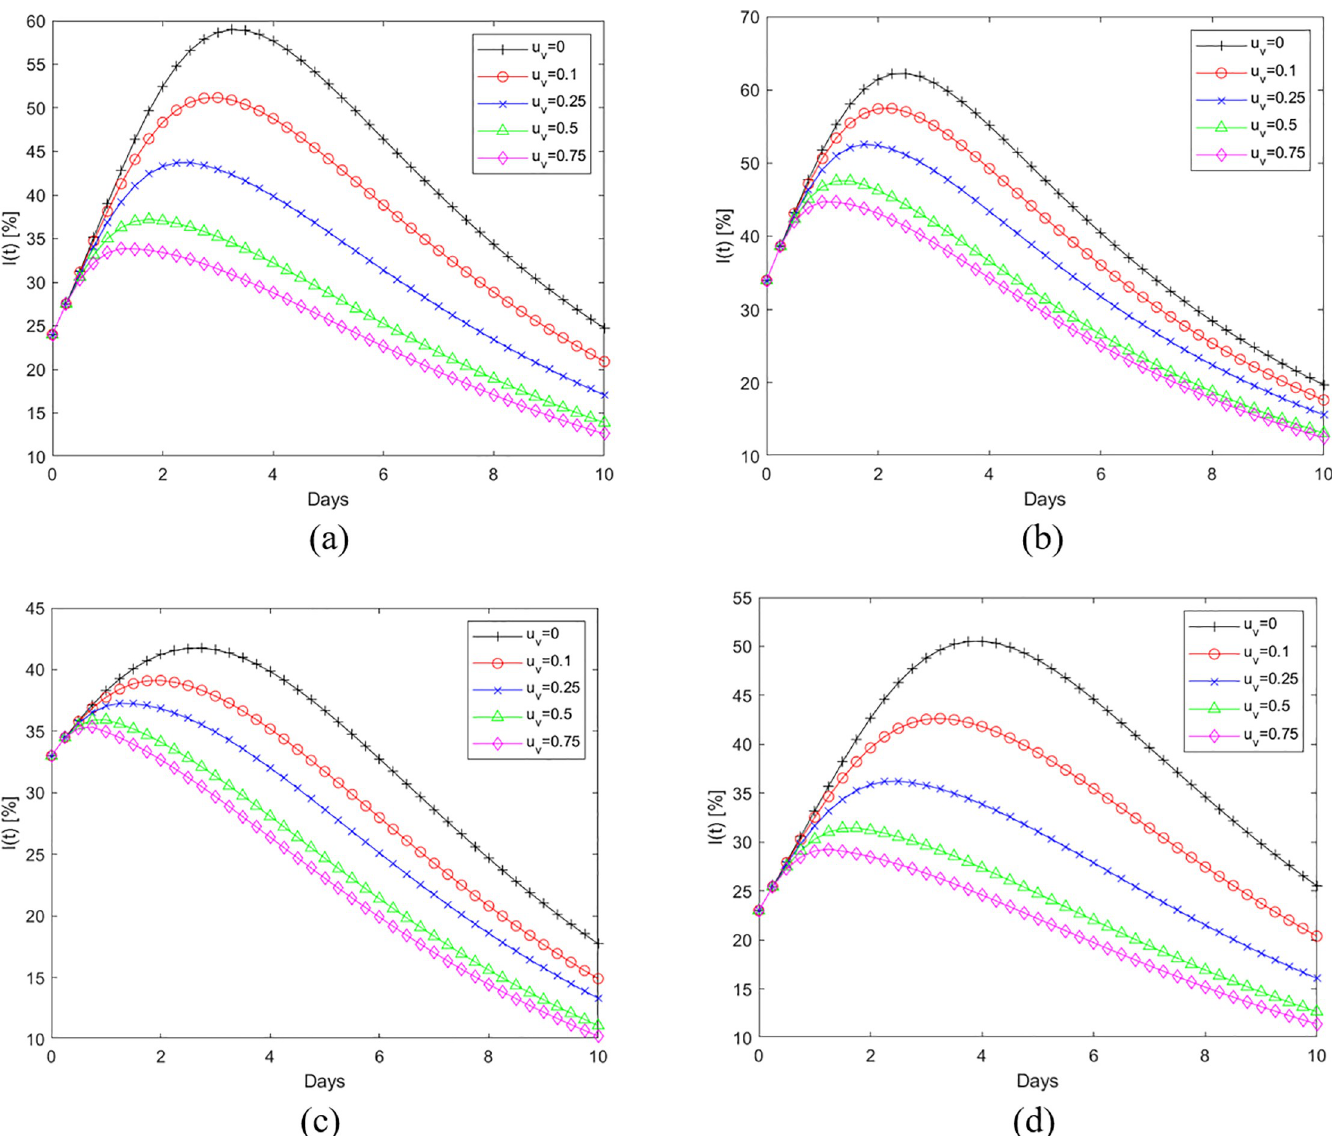
Fig 8. The evolution of empty gas stations and the effect of optimal refueling strategy on other cities affected by Hurricane Irma (a) Miami-Ft Lauderdale, (b) Tampa St Petersburg, (c) Orlando and (d) Jacksonville.